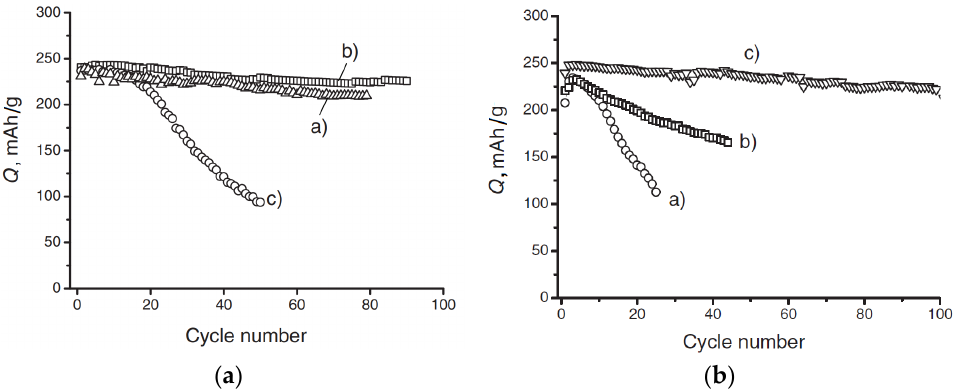
Figure 5. ( a ) Variation in reversible capacities for hard-carbon electrodes in (a) EC, (b) PC, and (c) BC solution containing 1 mol/dm 3 NaClO 4 tested at 25 mA/g. ( b ) Reversible capacities for hard-carbon electrodes in (a) EC:DMC (1:1), (b) EC:EMC (1:1), and (c) EC:DEC (1:1) solution containing 1 mol/dm 3 NaClO 4 at 25 mA/g. (Reprinted with permission from [66]. Copyright 2011, Wiley Online Library).